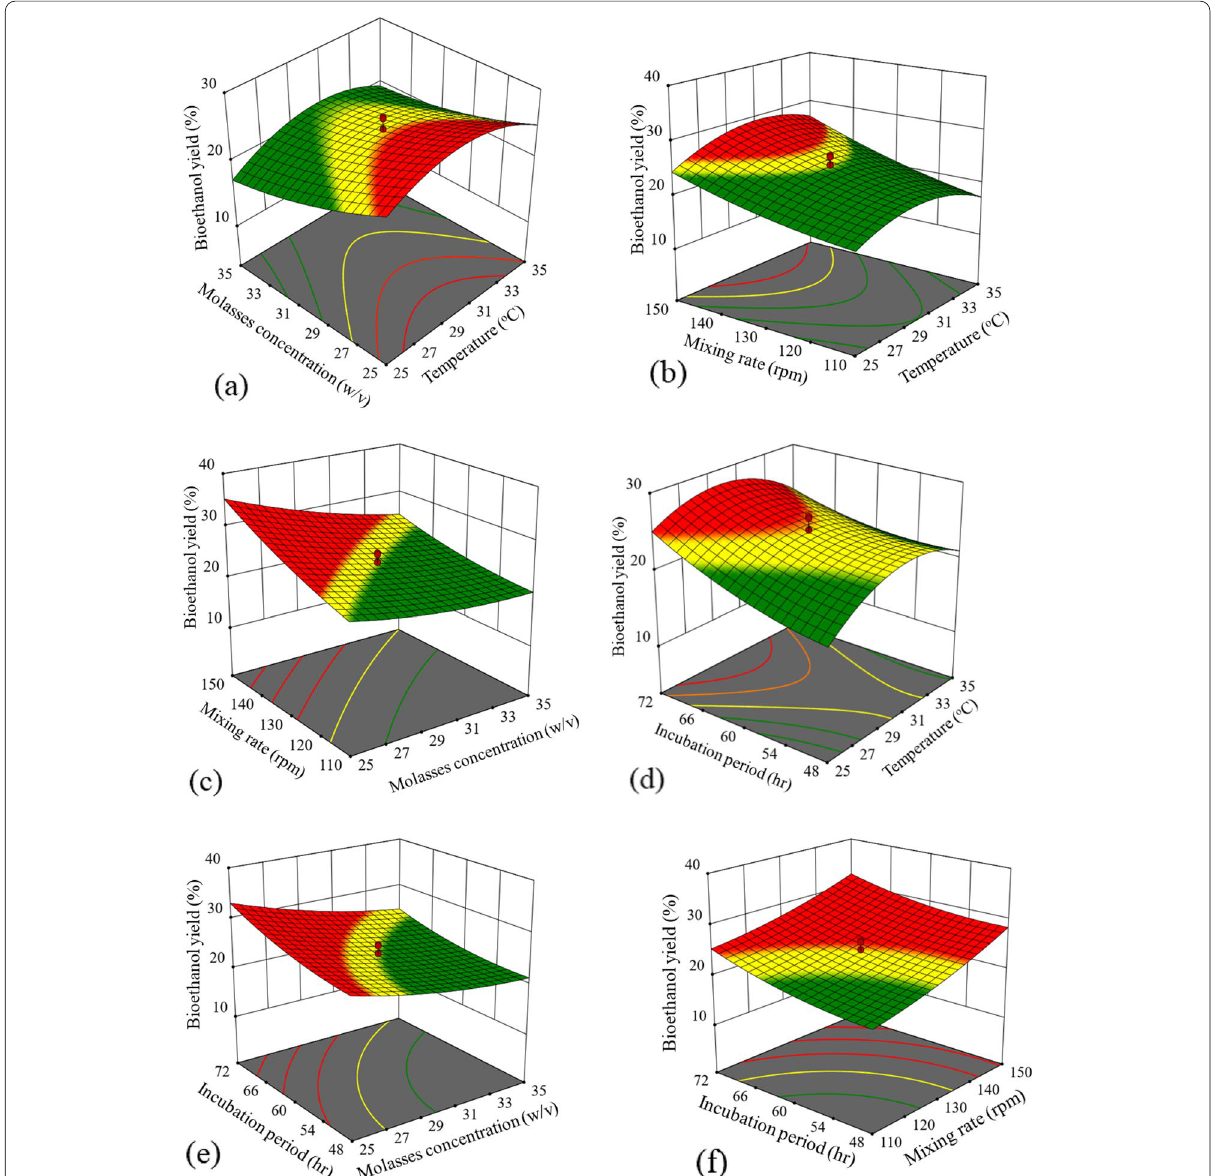
Fig. 6 The 3D response surface plots of ethanol yield of molasses concentration and temperature ( a ), mixing rate and temperature ( b ), mixing rate and molasses concentration ( c ), incubation period and temperature ( d ), incubation period and molasses concentration ( e ), and incubation period and mixing rate ( f ). Green, yellow, and red colors represent lower, medium, and higher levels of ethanol yield,